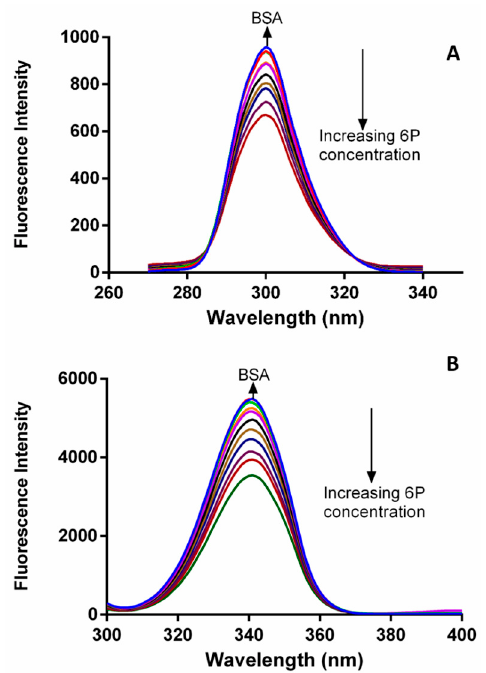
∆ λ = 15 nm and ( B ) ∆ λ =